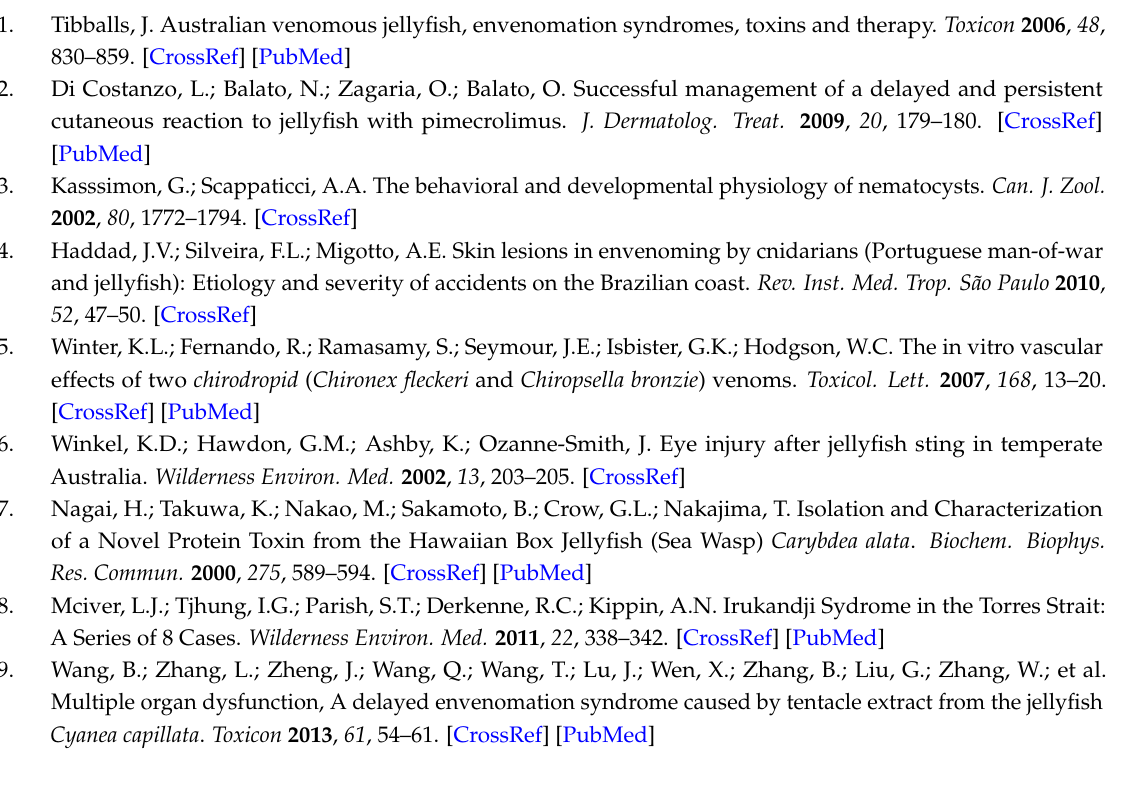
Table S1: Socio-demographic information, Table S2: Knowledge about jellyfish